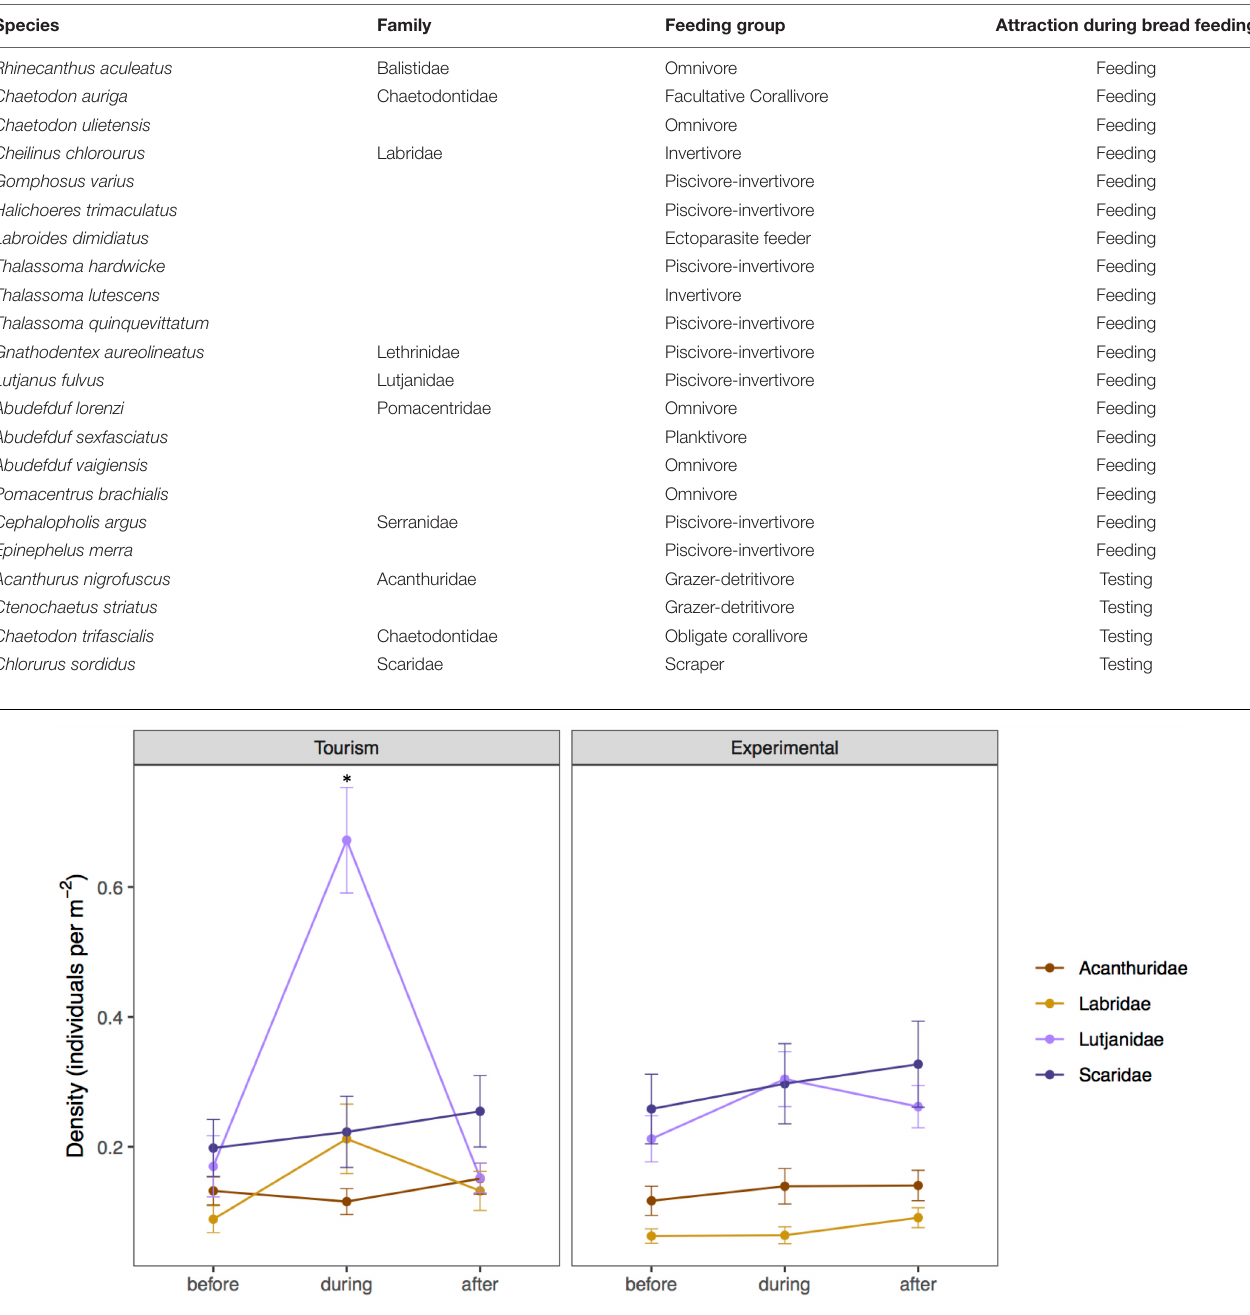
TABLE 3 | Fish species feeding on or testing bread when it was provided during artificial feeding event.